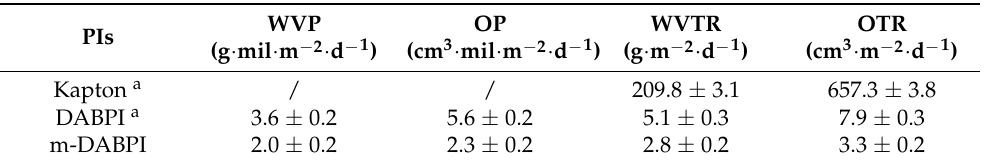
Table 2. Barrier properties of DABPI and m-DABPI